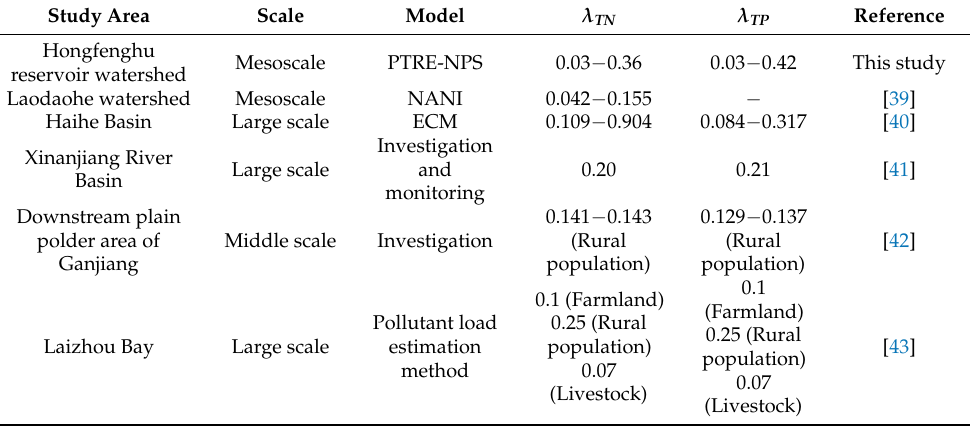
Table 5. Results of the other studies on the path-through rate of NPS pollution in